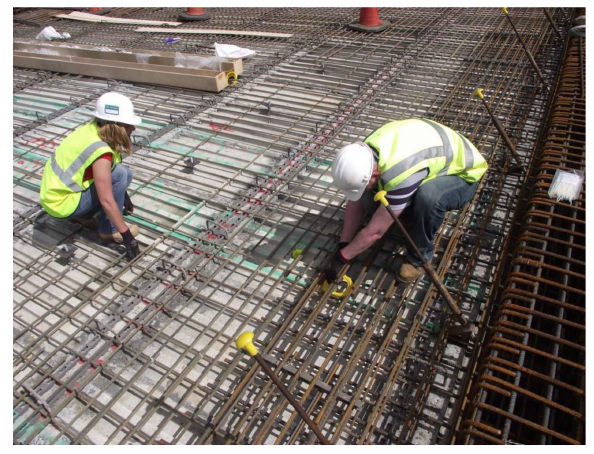
Figure 5. Positioning of the fiber bragg gratings (FBG) sensors.